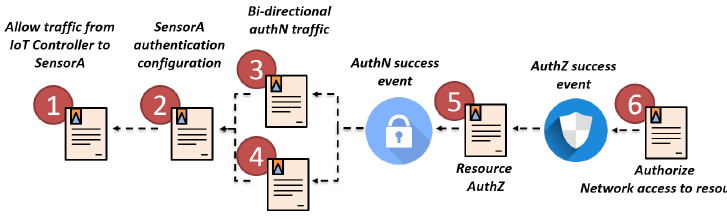
Figure 3. Policy dependencies example during Security